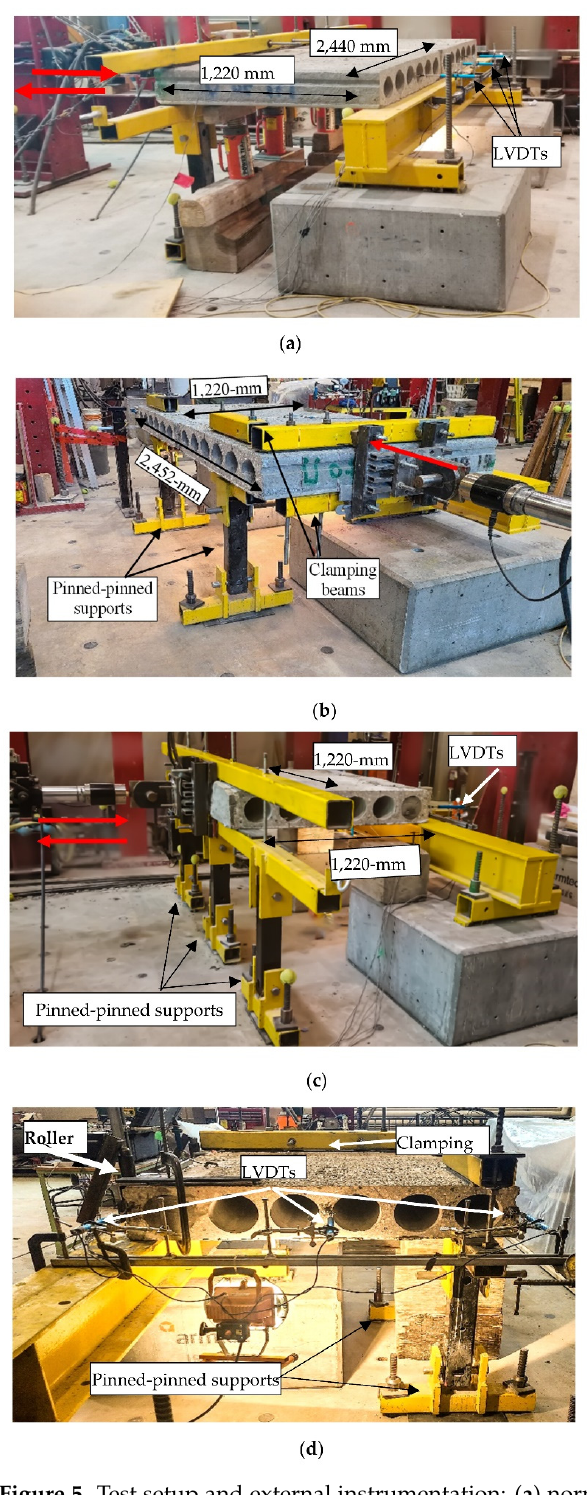
Figure 5. Test setup and external instrumentation: ( a ) normal load on end end-bearing specimen, ( b ) parallel load on end end-bearing specimen, ( c ) normal load on side-bearing specimen, and ( d ) parallel load on side-bearing specimen (Dimensions in mm).